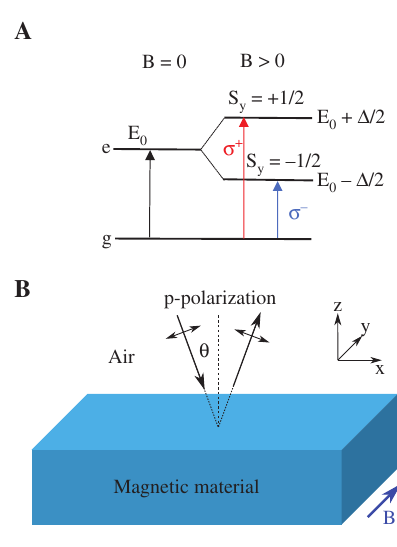
Figure 1: (A) Scheme of the optical transitions in a three-level system composed of the ground level (g) and two excited states (e), which are split off due to the Zeeman effect in magnetic field B | | y . (B) Geometry of the considered setting, where p -polarized light is reflected from a semi-infinite magnetic medium with a three-level resonance shown in